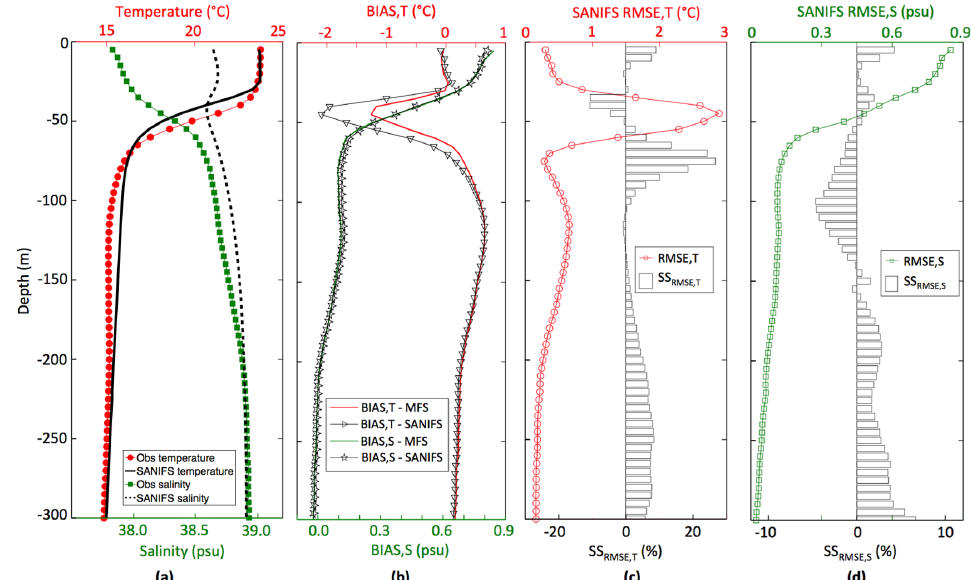
Figure 7. SANIFS average profiles (temperature and salinity) compared with the observed ones for the LS1 (a) . Bias with LS1 observations of the MFS and SANIFS average profiles (temperature and salinity) (b) . Temperature RMSE for SANIFS (red line with circles) and RMSE skill score compared with reference model MFS for the LS1 (c) . Salinity RMSE for SANIFS (green line with squares) and RMSE skill score compared with reference model MFS for the LS1 (d) . RMSE skill score is represented by histograms (positive values highlight levels where SANIFS produces more accurate forecasts than MFS; conversely, negative values show the opposite).